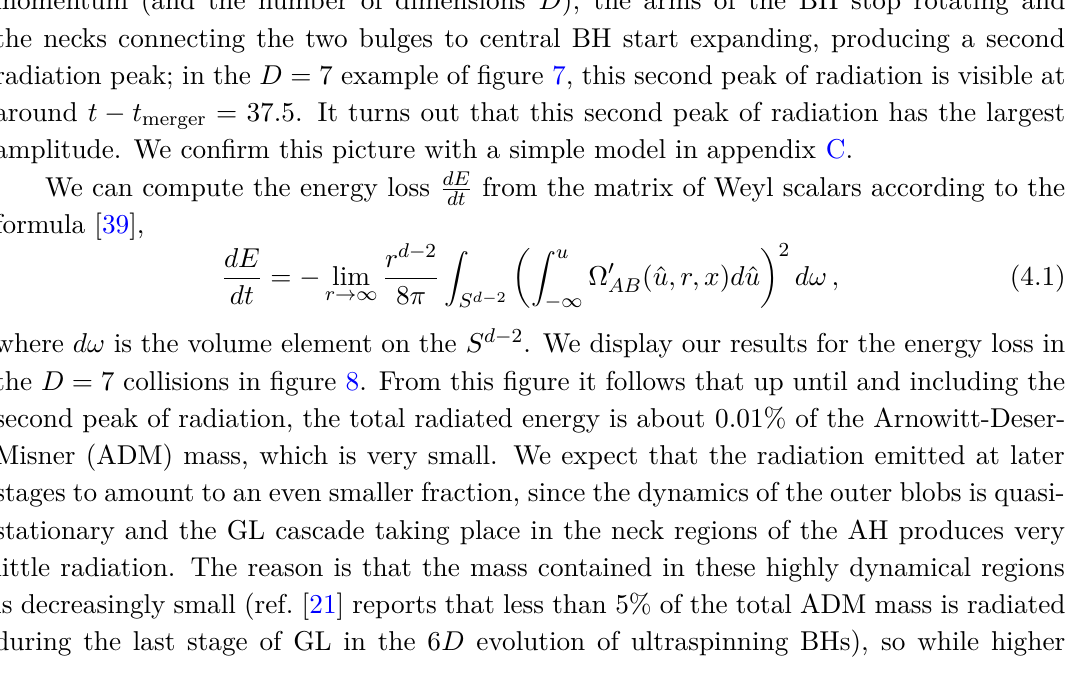
JHEP03(2022)111 ˜ (as K | χ 0 =0 . 6